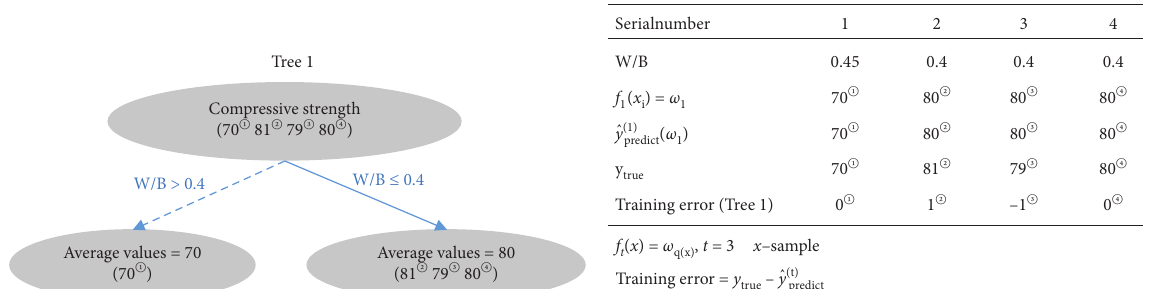
Figure 7: The training process of an XGBoost model (Tree 1).